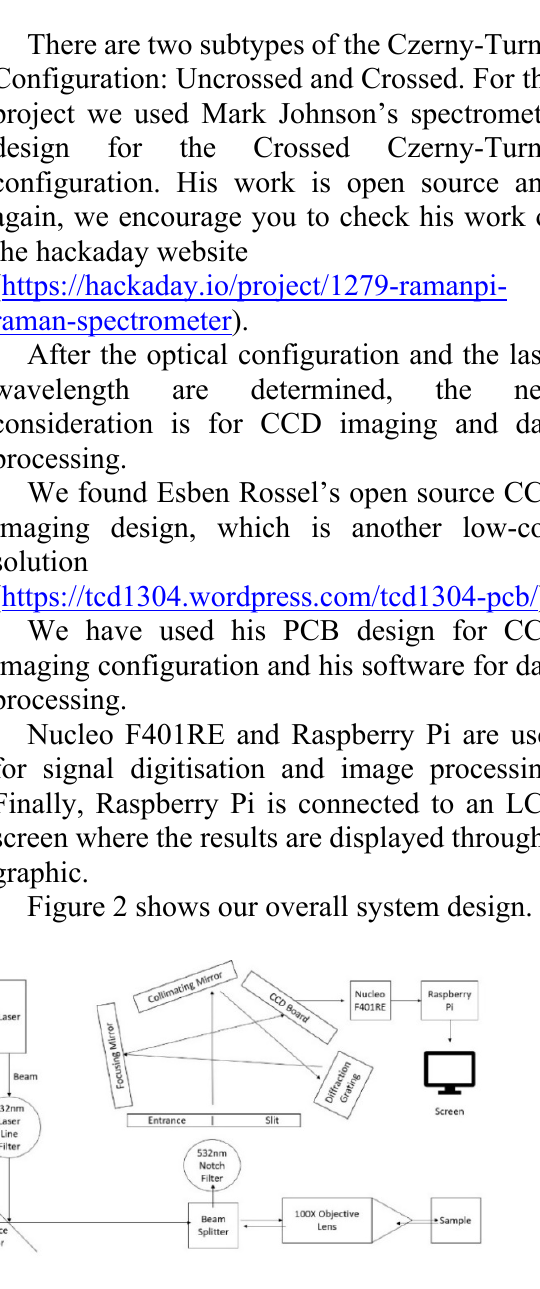
Fig. 2: Overall system design